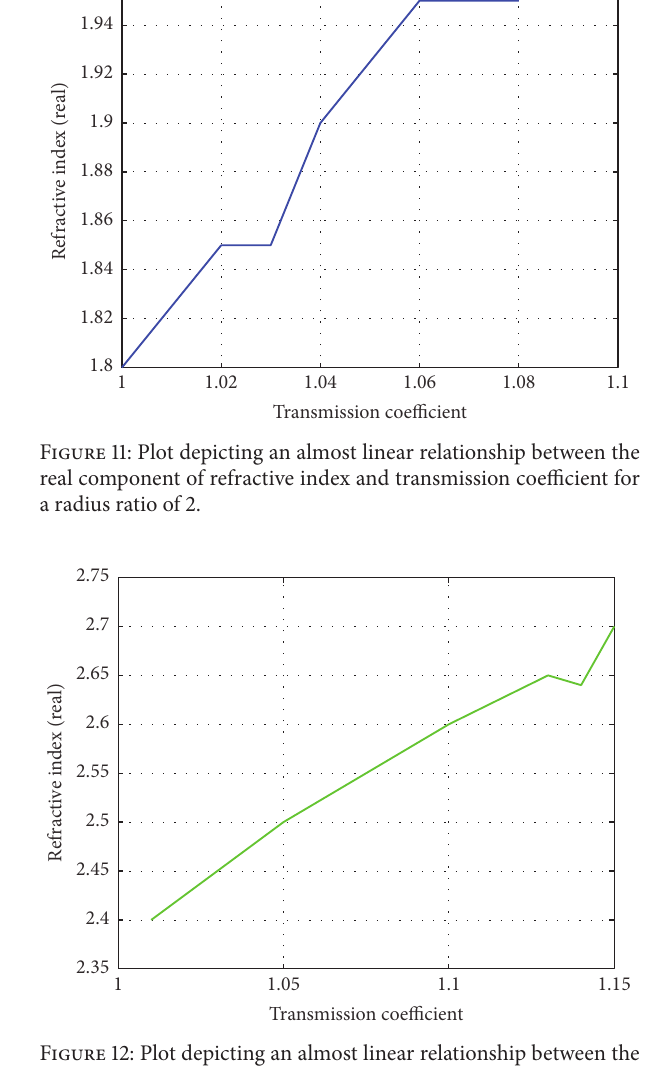
Figure 12: Plot depicting an almost linear relationship between the real component of refractive index and transmission coefficient for a radius ratio of